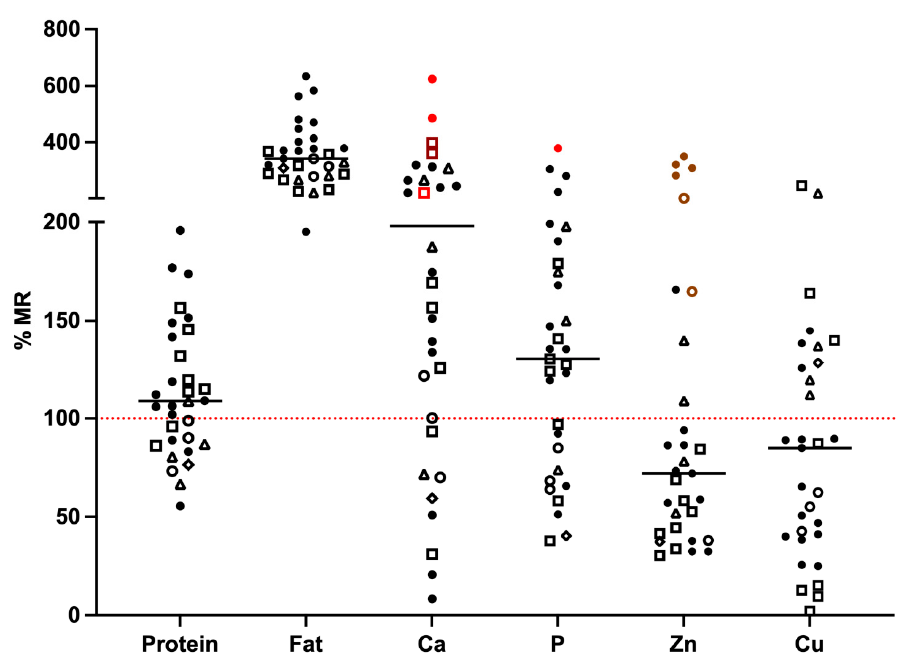
Figure 1. Selected nutrients measured in 31 RMBDs labelled as complete pet food [percent of FEDIAF minimum requirement] according to species and life stage. Full dot—adult dogs ( n = 15); empty dot—growing dogs ( n = 3); squared dot—dogs all life stages ( n = 8); triangle—adult cats ( n = 4); reverse squared dot—dogs and cats (adult + growth, n = 1). Black lines represent the medians. Red dot line represents 100% of FEDIAF minimum requirement according to species and life stage. For calcium and P content, red values exceed the maximum nutritional limit for growth or adult (light red) or both (dark red). For Zn content, brown values exceed the EU legal limit. MR: minimum requirement.